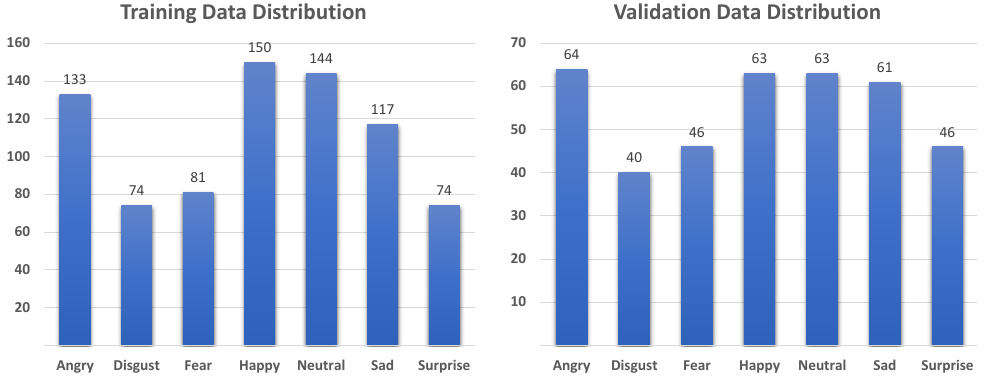
AFEW Dataset Figure 9. Data distribution for training and validation on AFEW dataset [33].